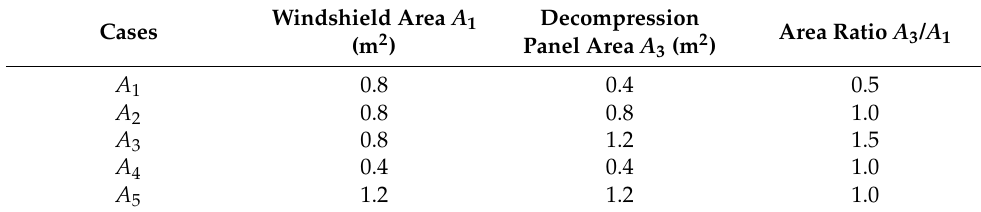
Table 7. Varying windshield areas and decompression panel areas.